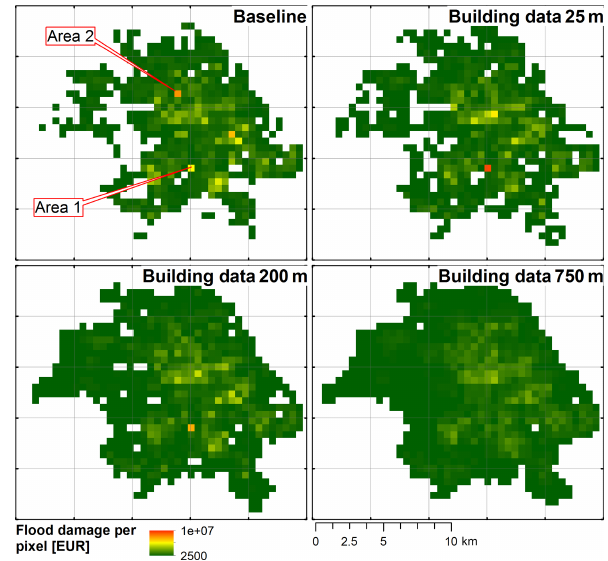
Figure 8. Flood damage predicted by DMOD1 on an aggregation level of 500, considering the baseline dataset and regression predic- tions generated with building data aggregated to resolutions of 25, 200 and 750m. Damage was computed using the framework doc- umented by Beckers et al. (2013) for a return period of 100 years. Flood areas and building data for the pixels named Area 1 and Area 2 are shown in Fig.